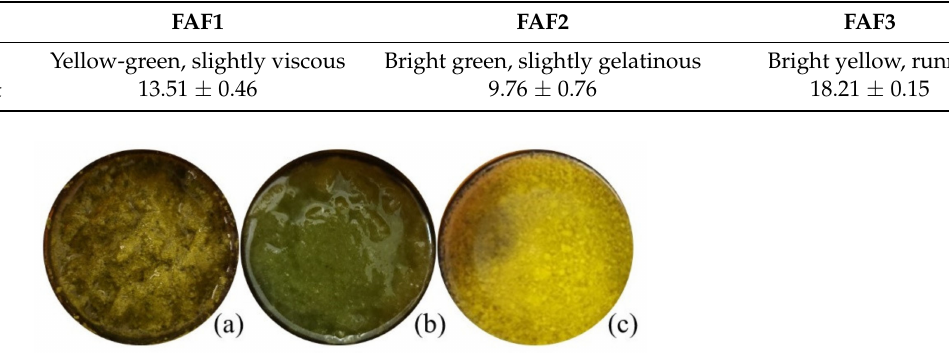
Figure 1. Macroscopic appearance of Matricaria recucita white ray floret supercritical fluid extracts under different combinations of temperature and pressure: ( a ) sample FAF1, ( b ) sample FAF2, ( c ) sample FAF3.